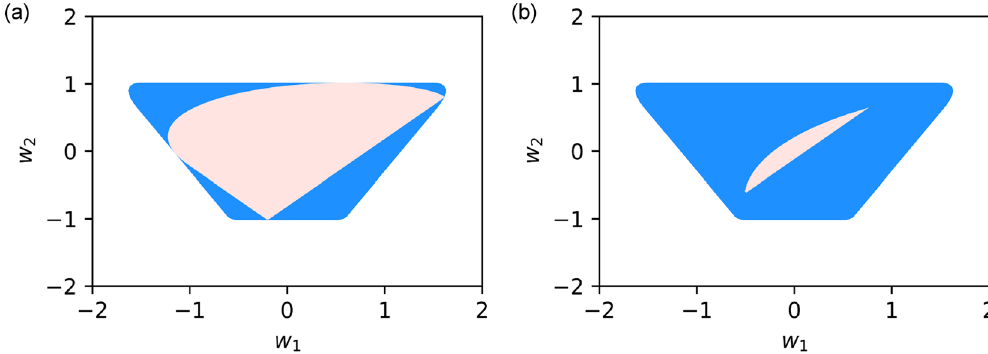
˜ p 2 N = 1 and the fixed n n = 1 (cid:31)